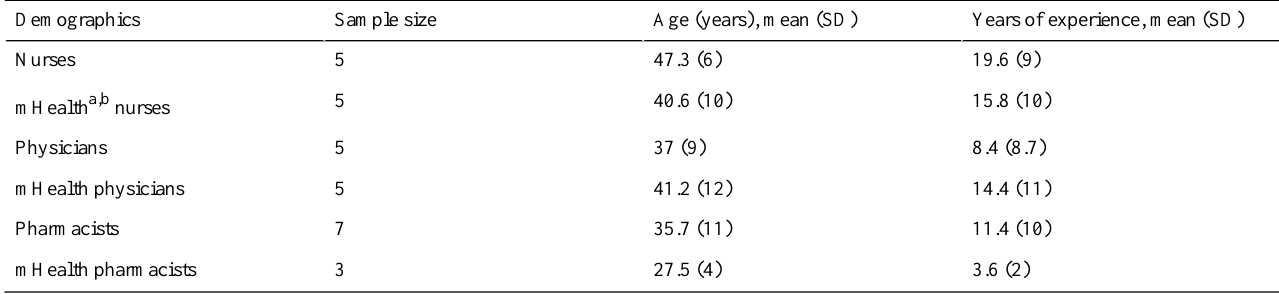
Table 1. Participant